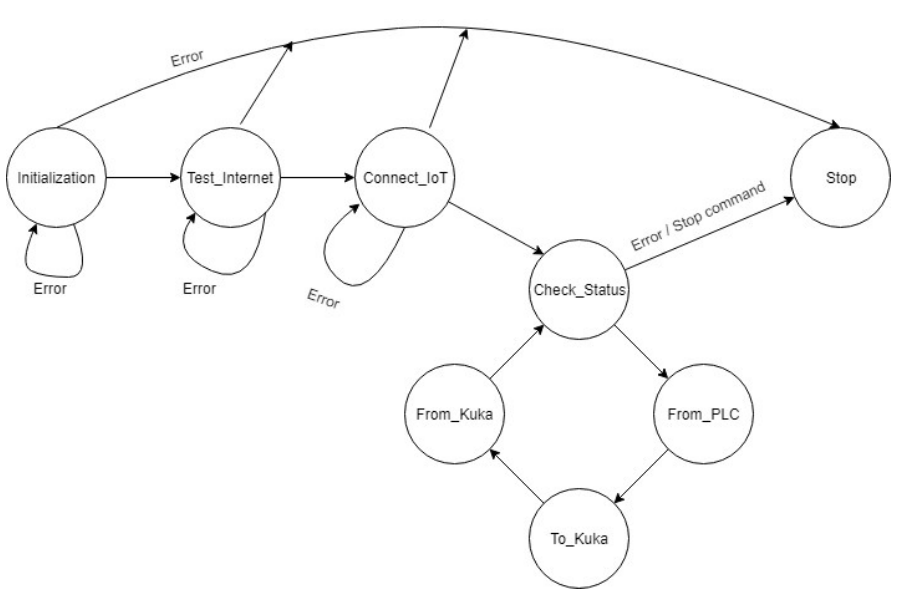
Figure 9. Producer loop state